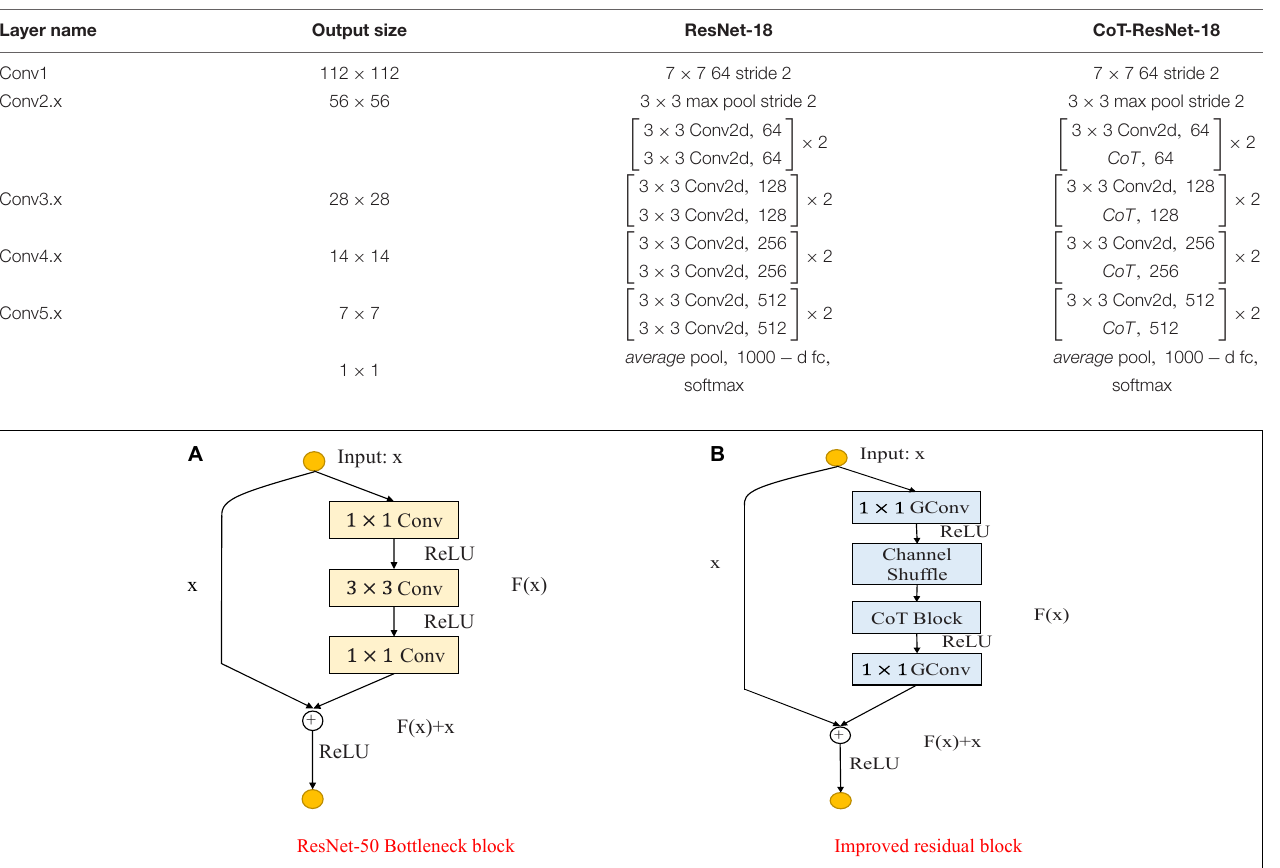
TABLE 1 | Comparison of ResNet-18 and CoT-ResNet-18.